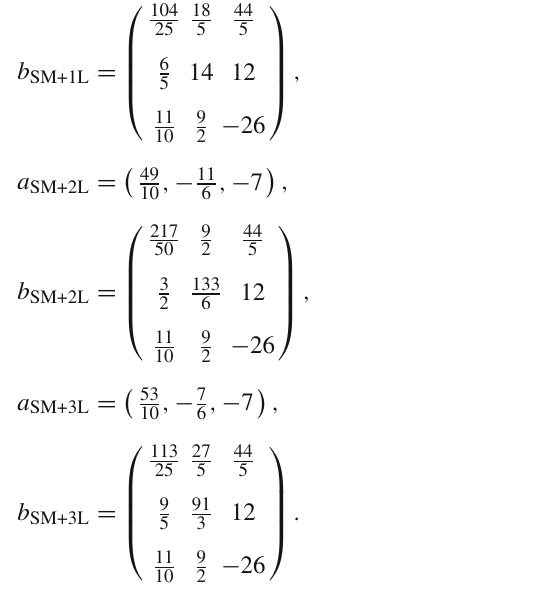
Fig. 11 Influence of the 3 generations of exotic E 6 lepton doublets ( 1 , 2 , 3 ) with a mass splitting m / m (cid:11) 10 − 2 , m / m (cid:11) 10 − 4 2 L 3 L 1 L 3 L on the unification of the gauge couplings. The numbers in the lower-left corner indicate the mass scale of the heaviest vector-like lepton doublet ineachscenario.Scenarioswithavector-likeleptondoubletlighterthan 450GeVarealreadyruledoutbycollidersearches[67].Thedashedline represents the Grand Desert scenario with no particles at intermediate scales. The light gray points indicate possible threshold corrections with R ∈ [ 1 / 20 , 2 ] . With the heaviest lepton generation around m 3 L (cid:11) (cid:11) 10 16 10 14 GeV, the E 6 scale can be as high as M max E 6